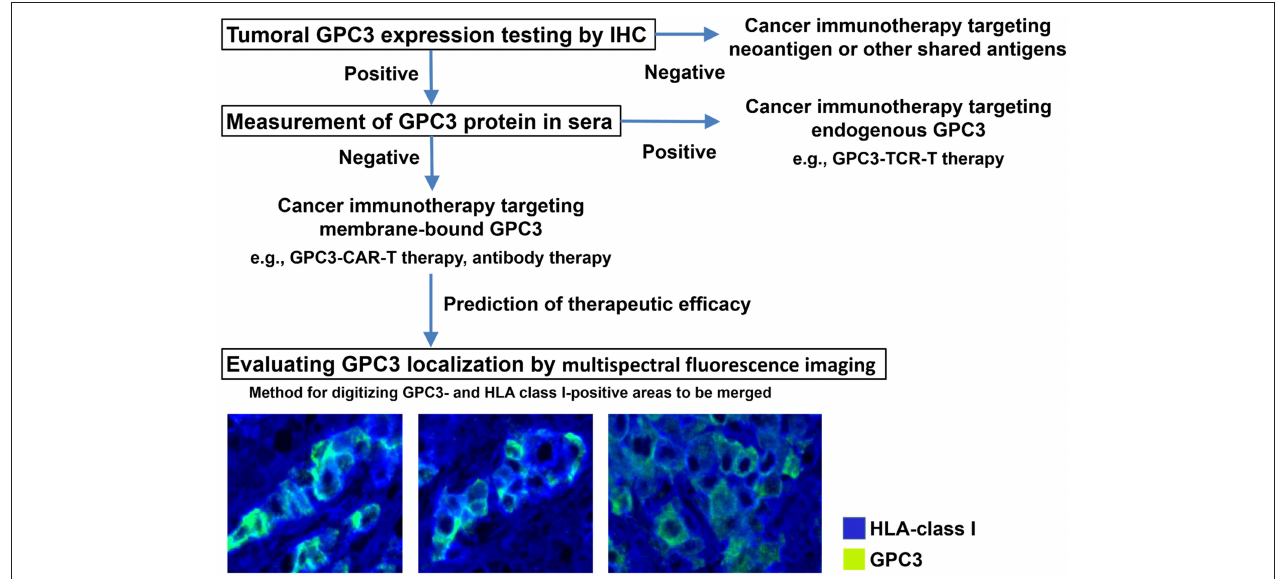
FIGURE 3 | Appropriate treatments targeting GPC3. Analyzing tumor GPC3 expression in combination with serum GPC3 level can reveal the most effective therapeutic strategy. To determine whether GPC3 is predominantly expressed at the cell membrane—which is thought to influence the efficacy of therapies